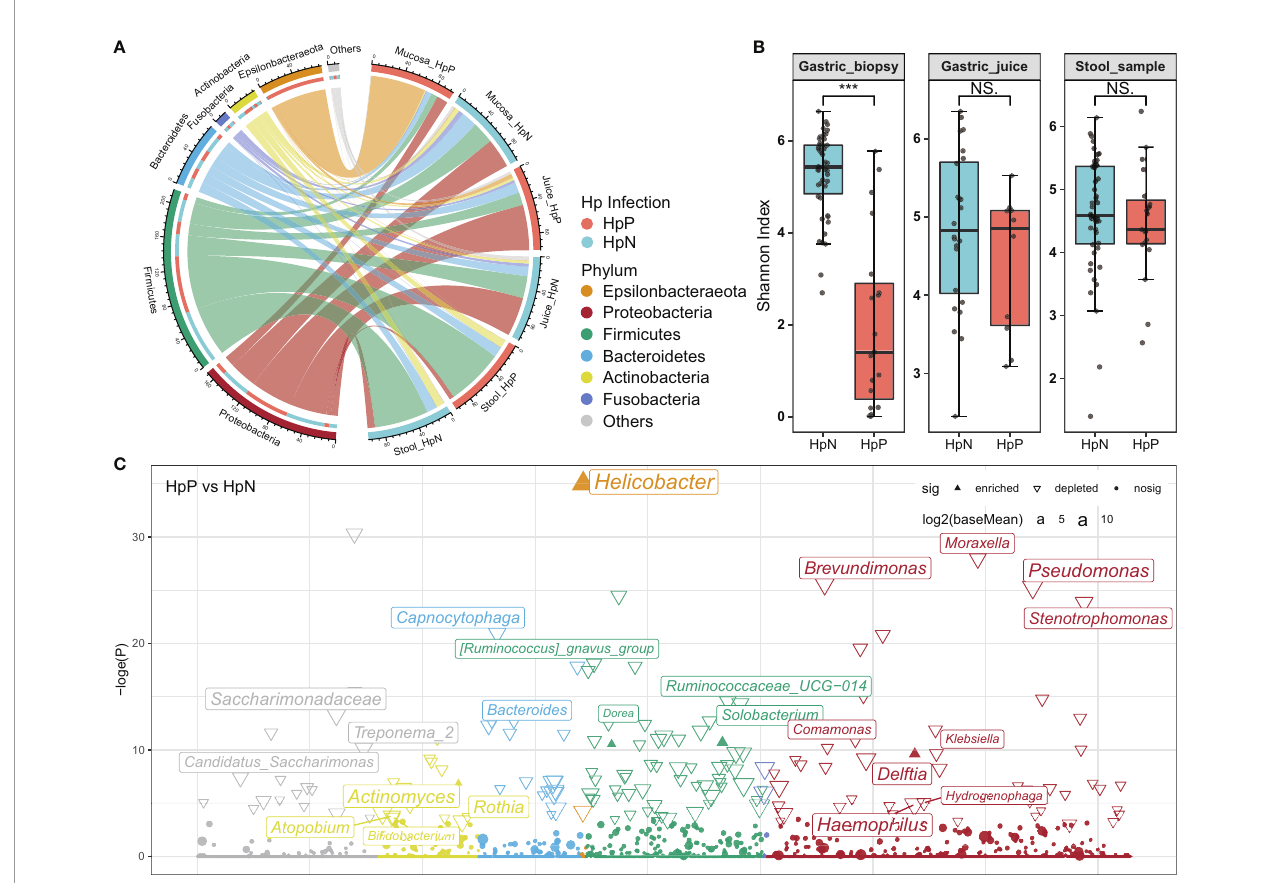
FIGURE 1 | The in fl uence of H. pylori on gastrointestinal microbiota composition and diversity. (A) The abundance of the gastrointestinal microbiota is shown at the phylum level. (B) Bacterial diversity was estimated by the Shannon index for HpP and HpN groups. (C) Association of speci fi c bacteria taxa with H. pylori infection was identi fi ed by DESeq2 with adjusted p < 0.05. HpP, H. pylori -positive; HpN, H. pylori -negative; NS, not signi fi cant, *** p <